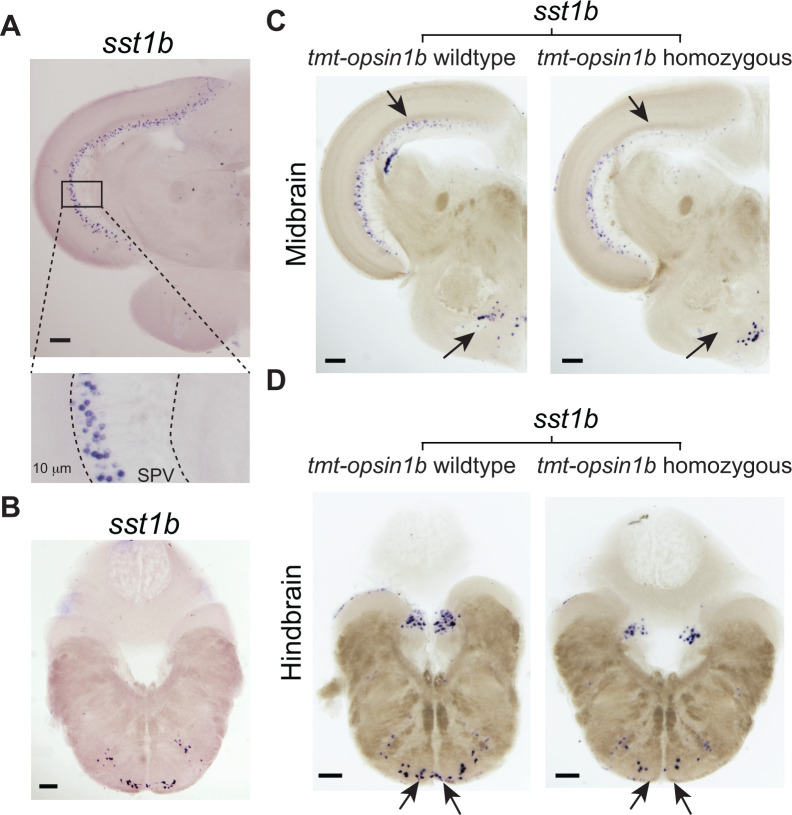
sst1b levels are reduced in specific cells in the tectum, posterior hypothalamus, and hindbrain in tmt-opsin1b−/− medaka brains.In situ hybridization for sst1b performed on coronal sections of midbrain (A) and hindbrain (B) from Cab wild-type fish. Magnification of boxed areas of the optic tectum are displayed below. SPV: stratum periventriculare. Note that sst1b expression identifies a distinct tectal population of dorsal cells and the ventral area of the hindbrain. (C, D) Comparison of sst1b expression in wild-type versus tmt-opsin1b mutant sibling coronal brain sections reveals specific reduction (denoted by arrows) in interneurons of the tectum and reticular formation, and in the posterior hypothalamus. Scale bars: 100 μm. Further details on anatomical annotations and co-localization of sst1b with gad2, as well as Scn12aa orthology relationships and localization: S6–S9 Figs.